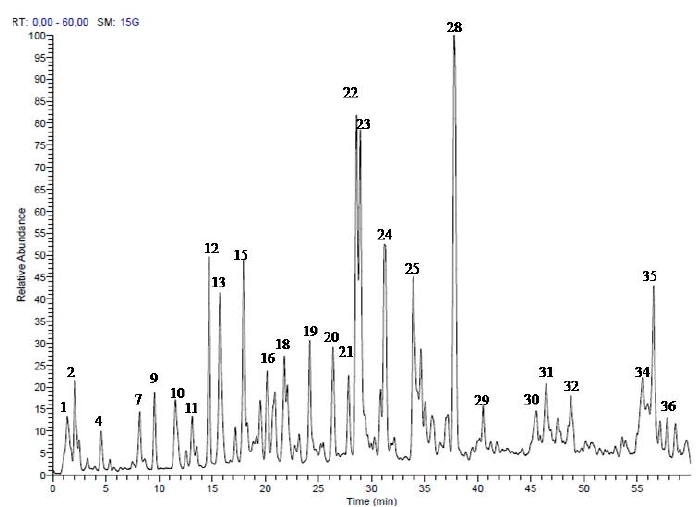
Figure 1. LC-MS profile of the methanol extract of S. singueana bark (LC-MS base peak in the negative ion mode). Table 1. Identification of secondary metabolites of the methanol extract from the bark of Senna singueana by HPLC-MS/MS.